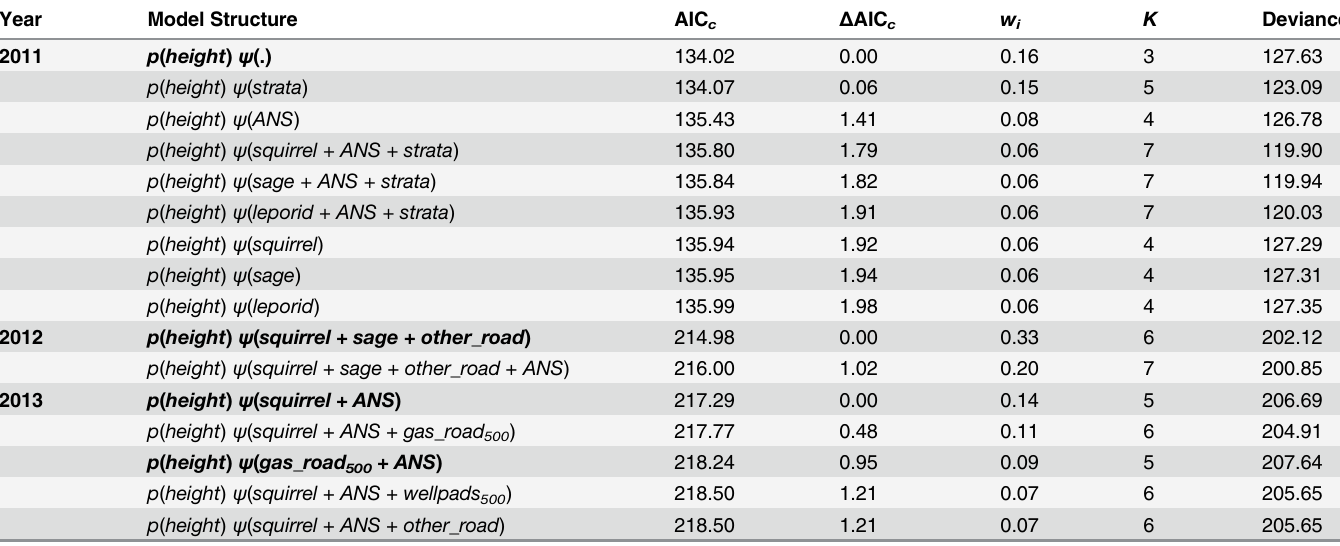
Table 1. Competitive models of detection and re-occupancy probabilities for ferruginous hawks in Wyoming, USA. Year Model